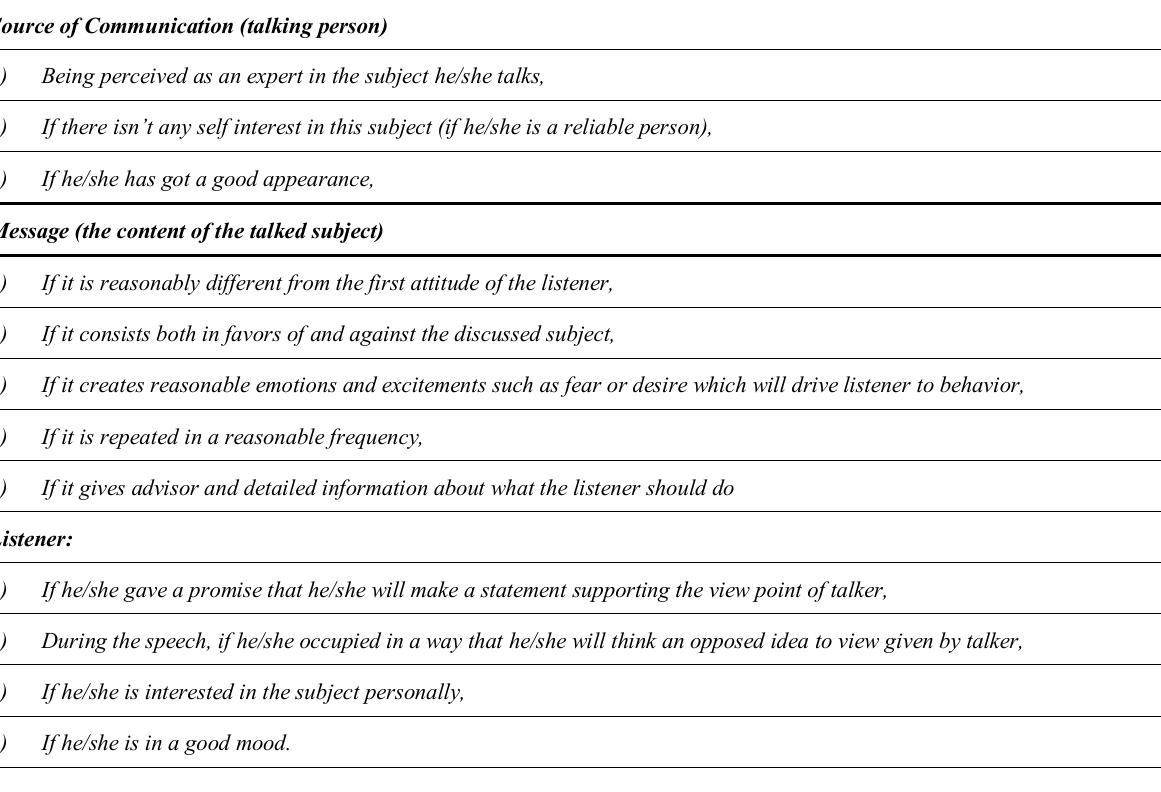
Table 2. Verbal Communication Factors Affecting the Attitude